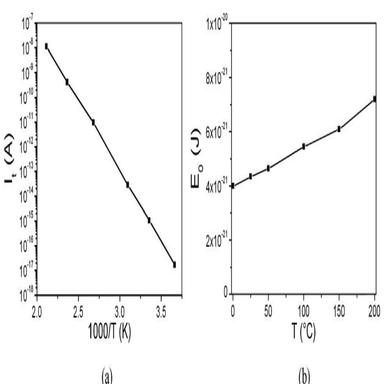
(a) Temperature dependence of tunneling saturation current It (a) and tunneling energy E0 (b) of power SiC Schottky diode.